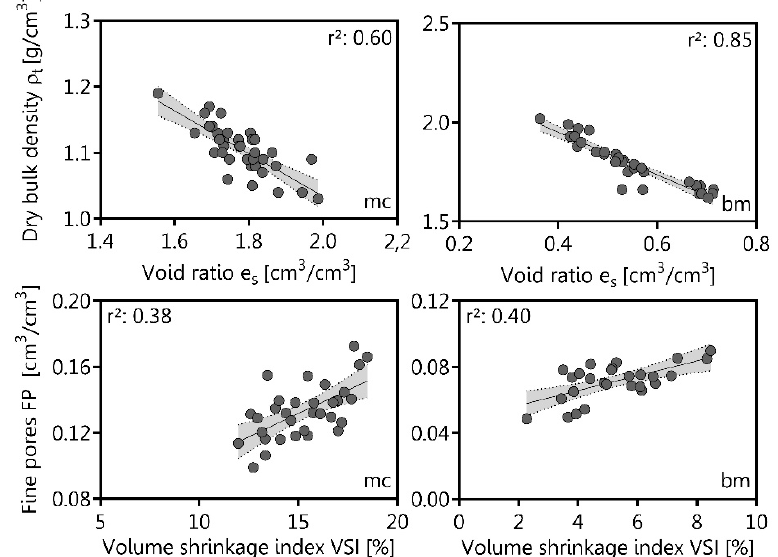
Figure 5. Volume shrinkage indices as a function of the fine pores (FP) and the void ratio, as a function of the dry bulk density ( ρ t), of marsh clay (mc, n = 40) and boulder marl (bm, n = 40) with regard to the regression function, respectively. The r 2 indicates the coefficient of determination. The dashed lines indicate the confidence limits for a confidence level of 95%.